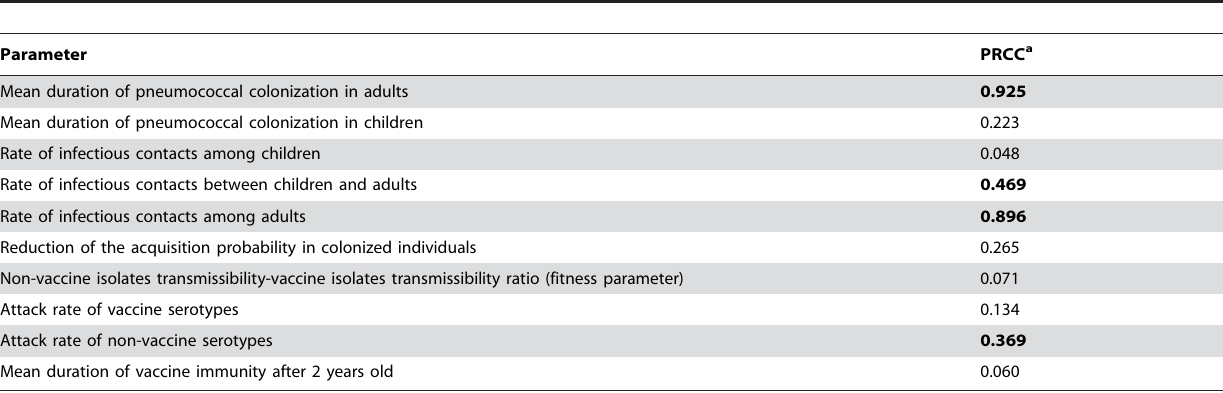
Table 4. Sensitivity analysis of the incidence of IPD 5 years after the introduction of conjugate vaccination. Vaccination coverage is fixed at 90% and the frequency of vaccine-selected capsular switch is fixed at 10 2 3 /week. Critical parameters are in